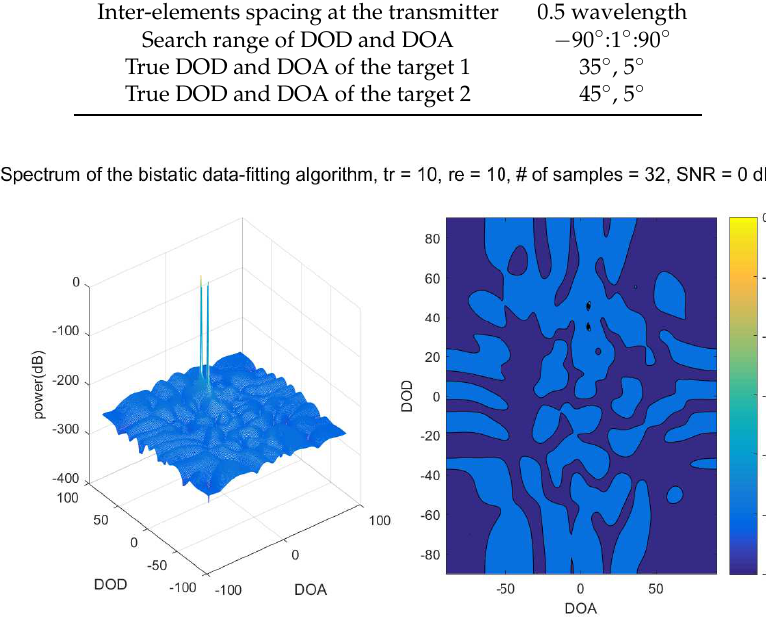
Figure 11. Spectrum of the bistatic data fitting DOD/DOA estimation algorithm, SNR = 0 dB.